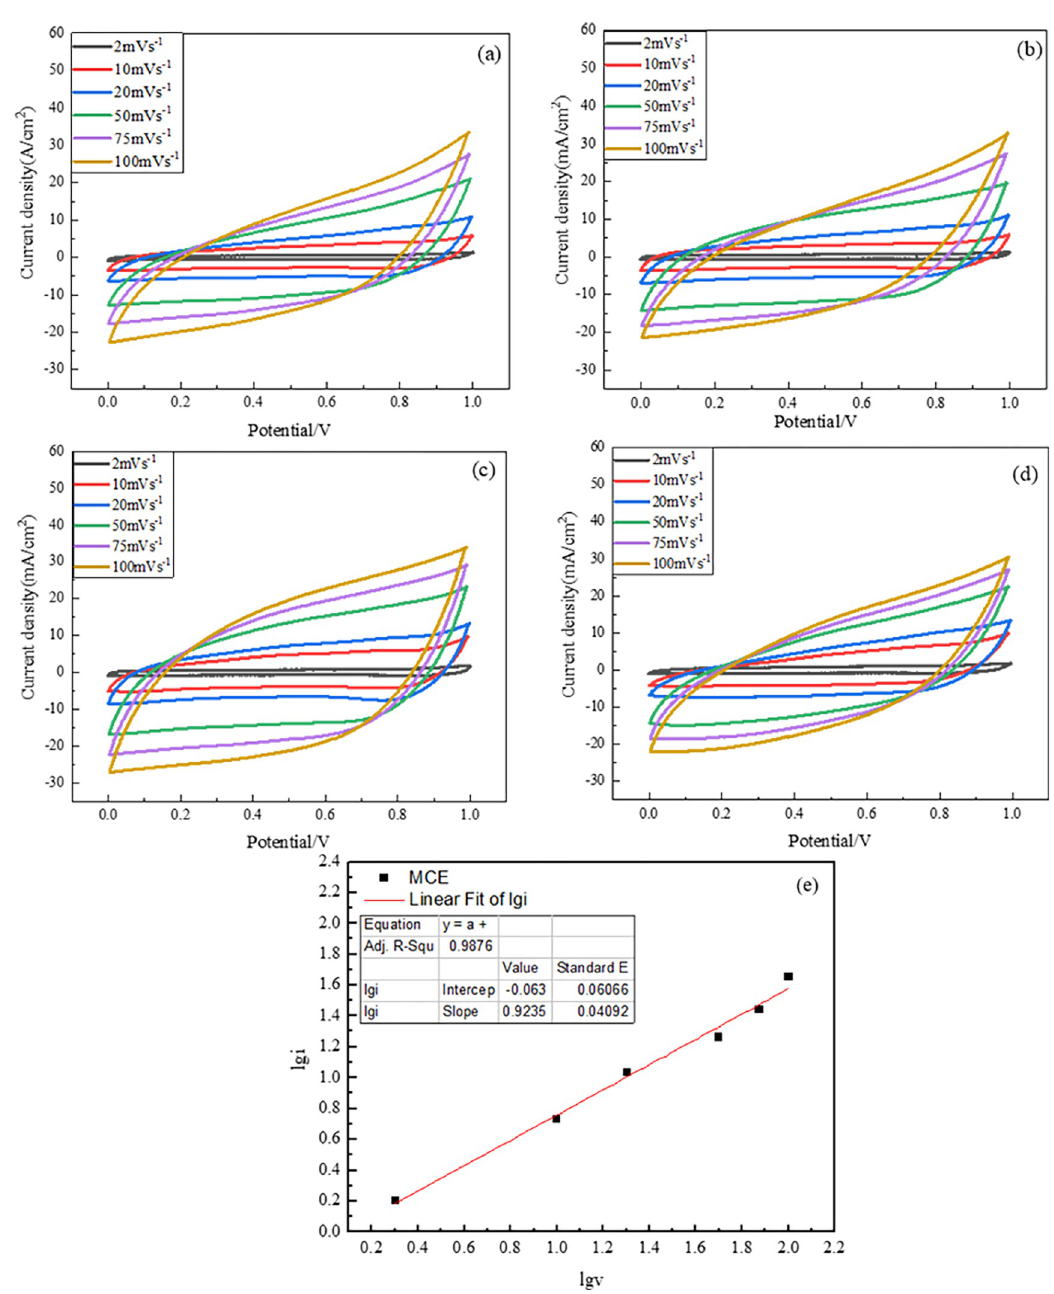
Fig 6. CV density curves collected for (a) product M (b) product MC (c) product MCD and (d) product MCE electrodes at various scan rates, (e) the typical calculated b value from CV curves for MCE. Charge—discharge curves of electrode material were obtained at different current densities (1 A g -1 , 2 A g -1 , 5 A g -1 , 10 A g -1 , 15 A g -1 and 40 A g -1 ) as shown in (Fig 7A–7D). The symme- try of the charge—discharge curves indicates that all the material electrodes have good electro- chemical reversibility. Specific capacitance can be calculated according to the charge— discharge curves. From the calculated capacitance values from GCD as shown in Fig 7(E), it